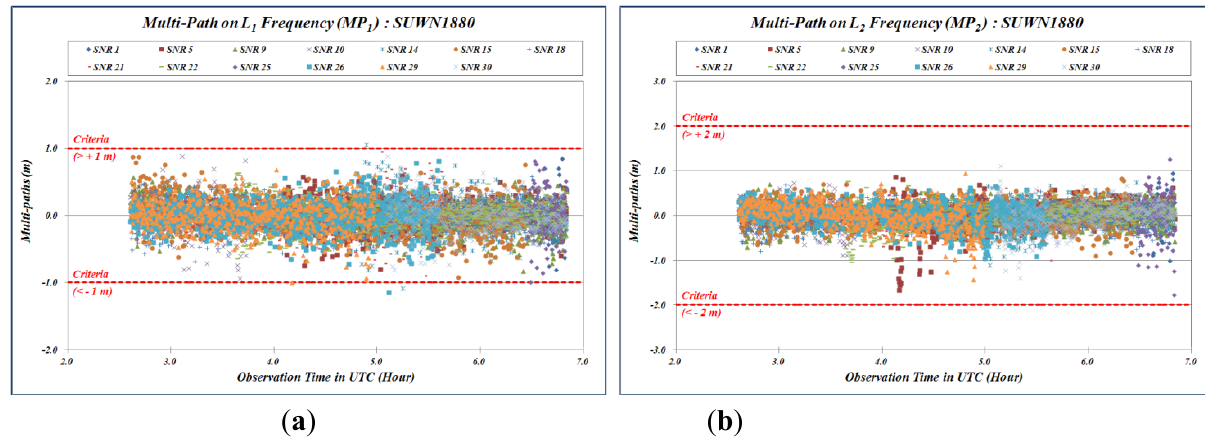
Figure 5. Quality control indicators related to multi-path effects. ( a ) Time-series plots of MP at each observation epoch. ( b ) Time-series plots of MP 1